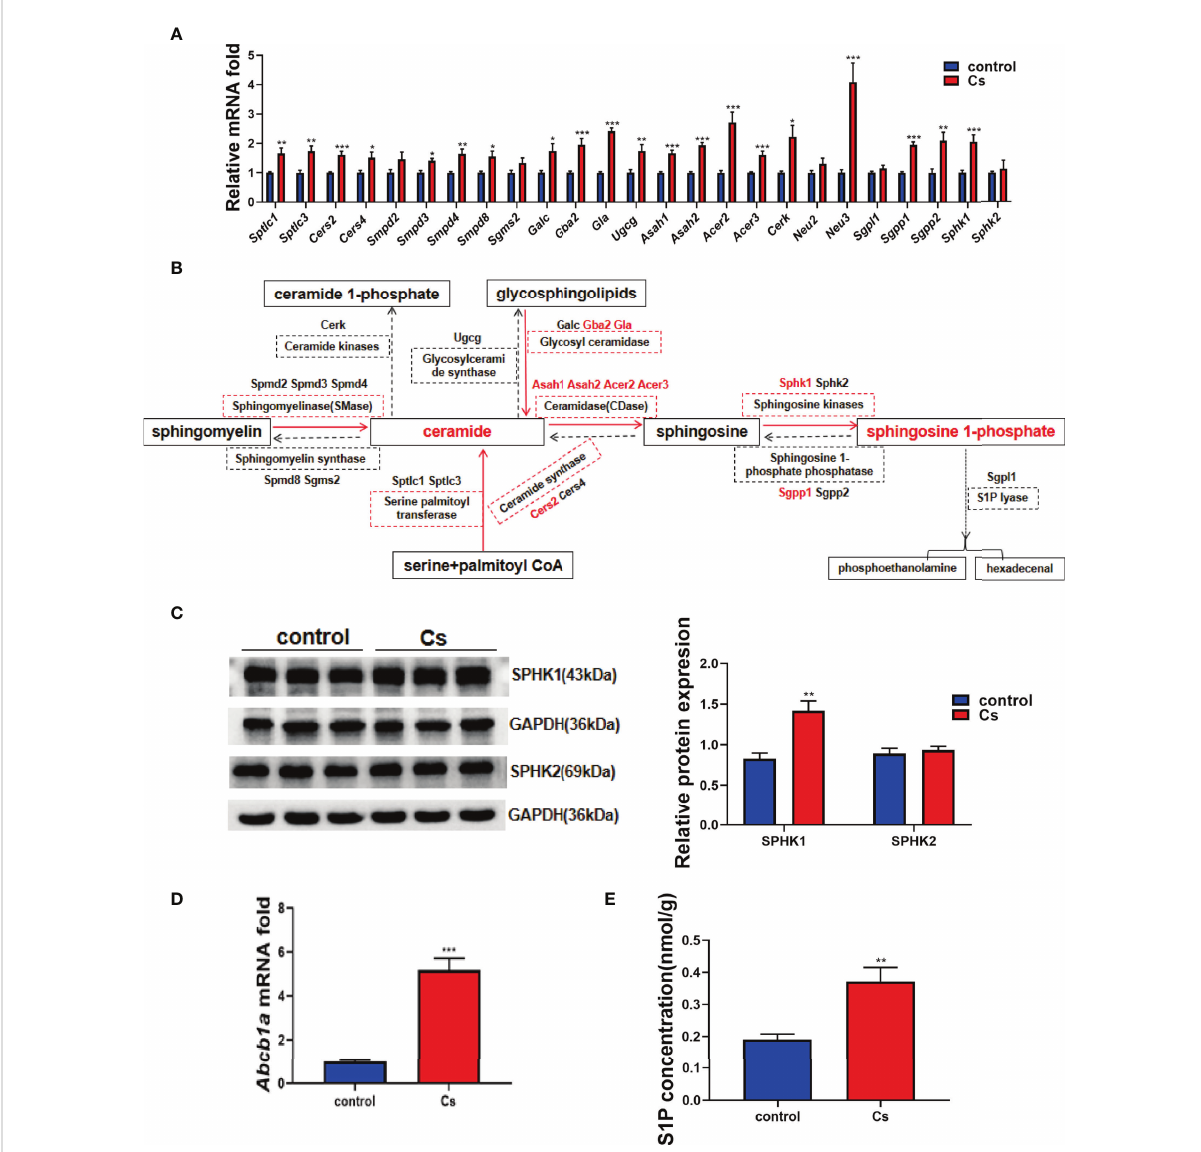
FIGURE 2 C. sinensis infection resulted in activation of sphingolipid metabolic pathways. (A) qRT-PCR assays were performed to measure the mRNA levels of enzymes involved in sphingolipid metabolic pathway, including Sptlc1, Sptlc3, Cers2, Cers4, Smpd2, Smpd3, Smpd4, Samd8, Sgms2 , Galc, Gba2, Gla , Ugcg, Asah1, Asah2, Acer2, Acer3, Cerk, Neu2, Neu3, Sgpl1, Sgpp1, Sgpp2, Sphk1, and Sphk2 . (B) The results schemed as a diagram. (C) Western blotting analysis of the protein expression levers of Sphk1 and Sphk2 in the liver of control and C. sinensis -infected mice. (D) The gene expression levels of ABC transporter protein. Measurement of the Abcb1a relative mRNA expression in liver tissue of control and C. sinensis infected mice. (E) The concentration of S1P in liver was determined by ELISA in control and C. sinensis -infected mice. Compared with control group, * P <0.05, ** P <0.01, *** P